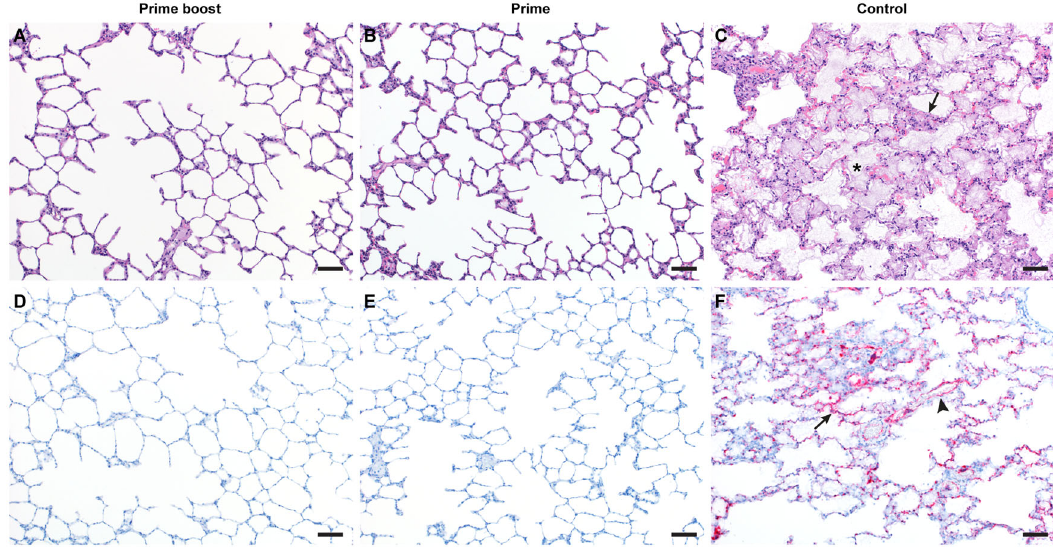
Fig. 4 Pulmonary effects of ChAdOx1 NiV vaccine ef fi cacy in the AGM model of NiV infection. A – C Lung tissue sections were stained with hematoxylin and eosin. A , B No pathology was observed. C Moderate to marked interstitial pneumonia with abundant fi brin (arrow) and edema (asterisk). D , F In situ hybridization for NiV RNA, resulting in a red stain. D , E No immunoreactivity was observed. F Immunoreactive vascular endothelium (arrowhead) and pneumocytes (arrow). Magni fi cation: ×100; bar = 50